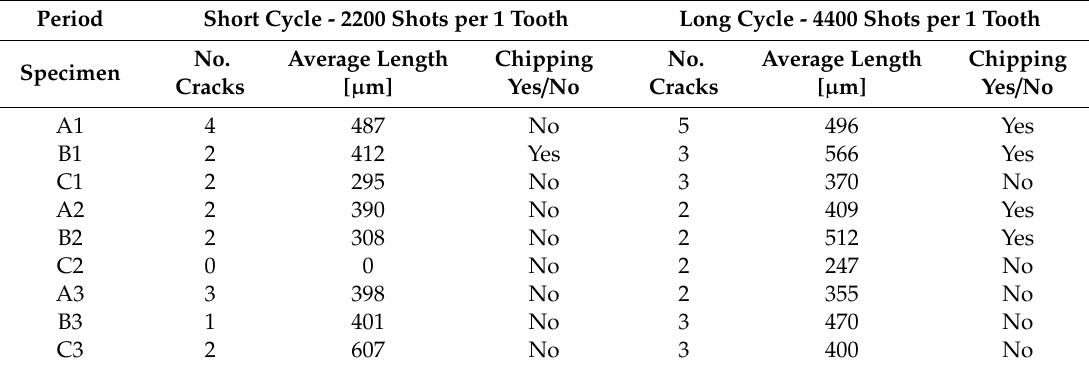
Table 8. Average length of thermal cracks.